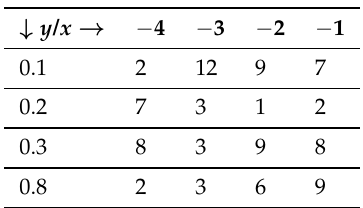
Table 1. Surface